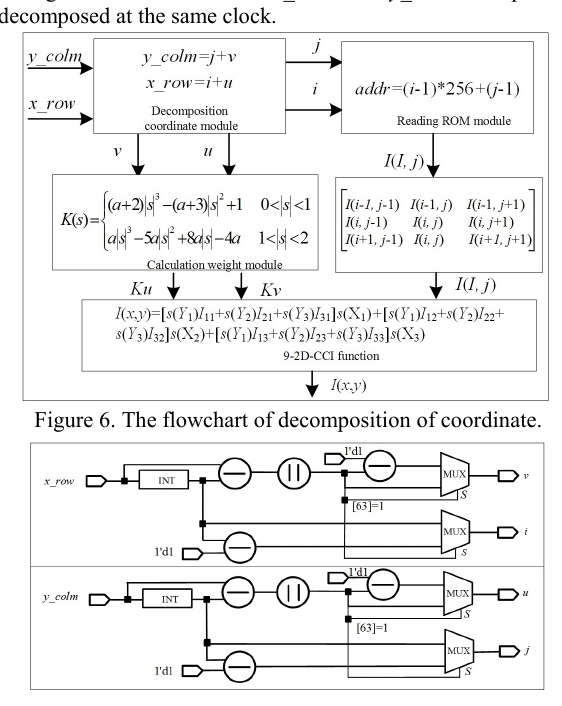
Figure 7. Parallel decomposition of the coordinate.